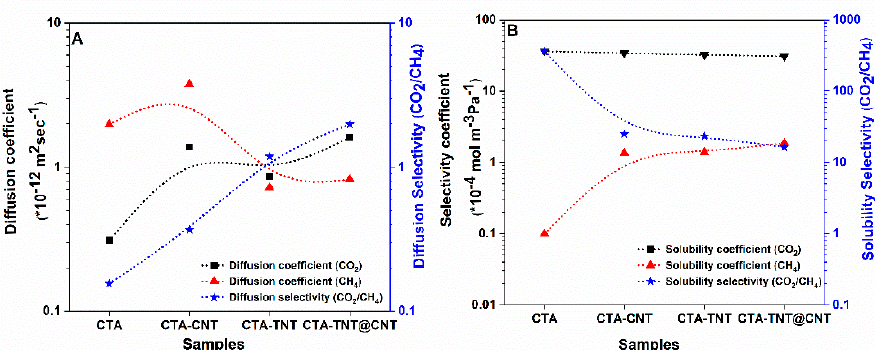
Figure 10. ( A ) Diffusion coefficient of CO 2 and CH 4 and their respective selectivities. ( B ) Solubility coefficient of CO 2 and CH 4 and the corresponding selectivities of the synthesized samples (dotted lines are a guide for the eye).